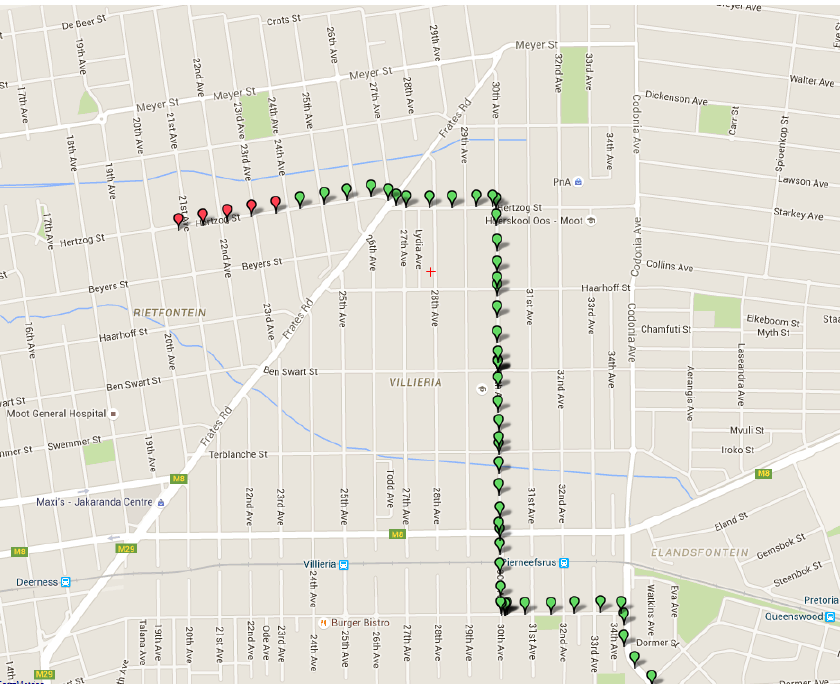
Figure 11. The retrieval, processing, and display of location information.